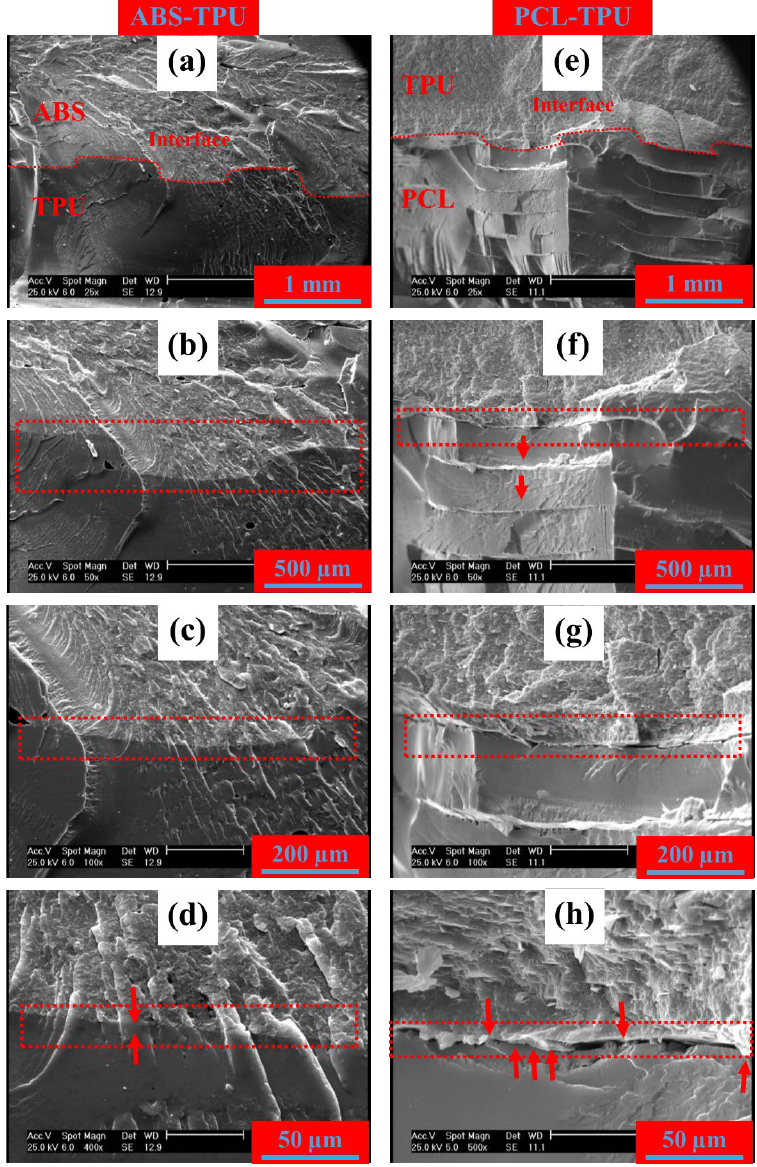
Figure 9. SEM photographs of ABS+TPU/TPU ( a – d ) and PCL/TPU ( e – h ) two-layer composite struc- tures printed samples’ interfaces with magnifications of 5×, 50×, 100×, and 400×/500×, respectively.